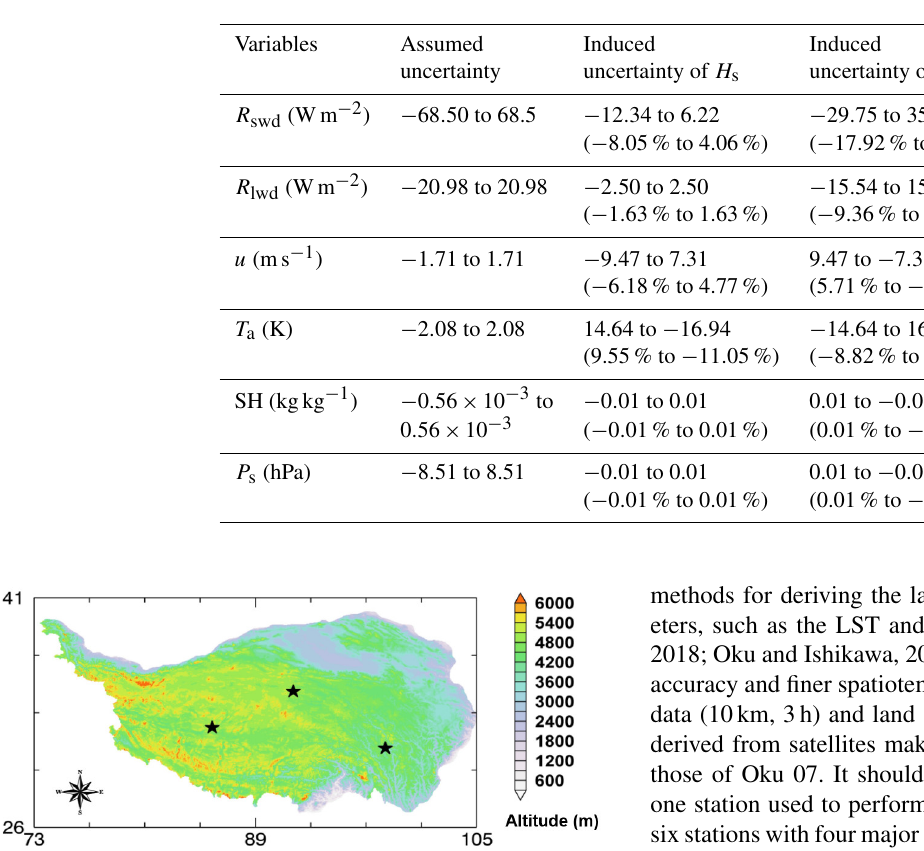
Table 5. Uncertainties for each meteorological forcing variable and the induced changes in H s and LE.